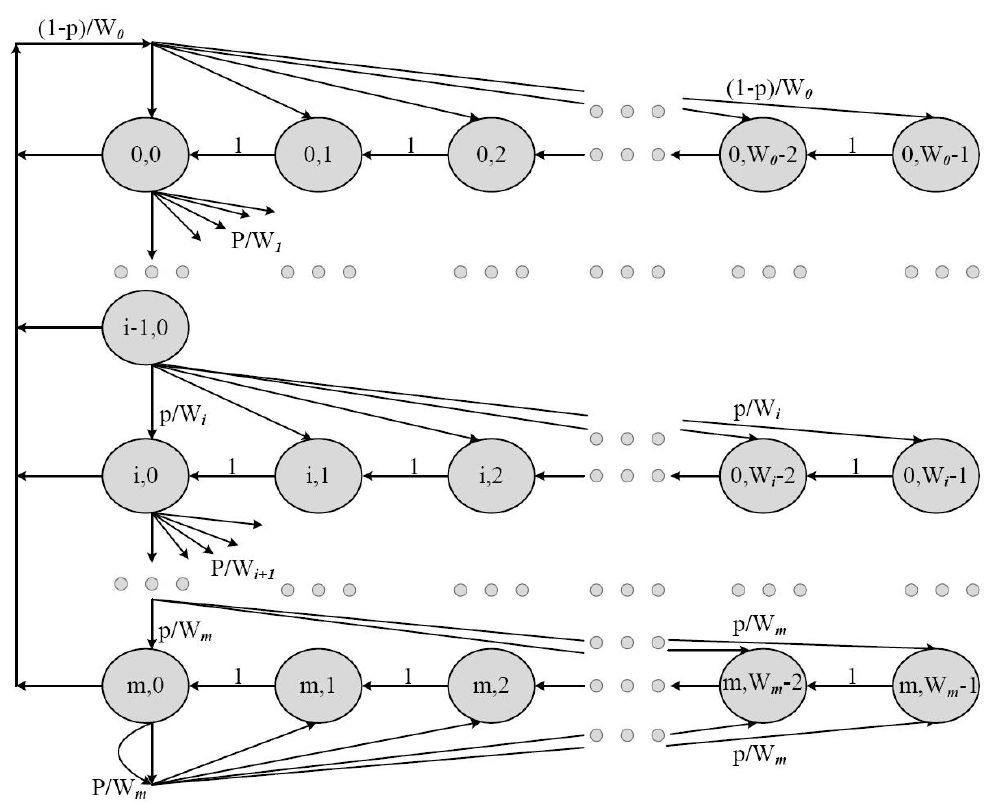
Figure 5. Markov chain model for the backoff window